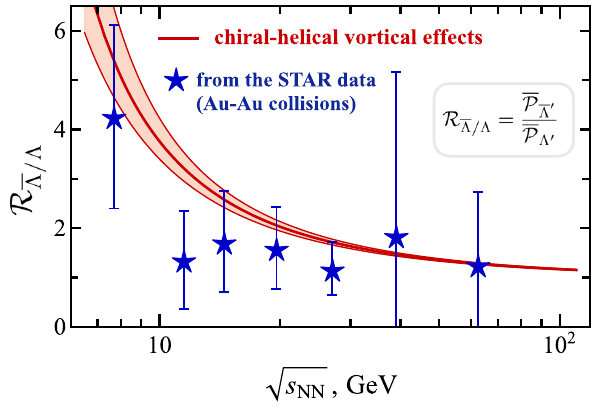
Fig. 3 Ratio R ¯ (cid:4)/(cid:4) = P ¯ (cid:4) (cid:12) / P (cid:4) (cid:12) of the average global polarizations P of anti-hyperons ¯ (cid:4) and hyperons (cid:4) , Eq. (18), in noncentral Au-Au collisions. The experimental data of the STAR collaboration [16] is compared with the analytical prediction coming from the chiral-helical vortical effects (19) with no fitting parameters used. The error bars of the data represent the statistical errors coming from the STAR experi- ment. The shadowed region corresponds to the confidence region of the analytical prediction coming from the chemical freeze-out parameters, Eq. (20) and Table